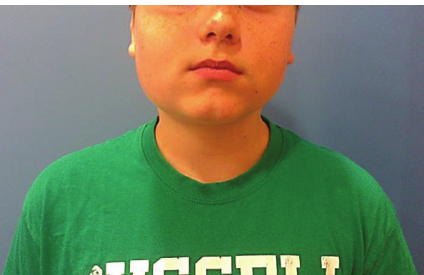
Figure 1: Evident asymmetry of the face.